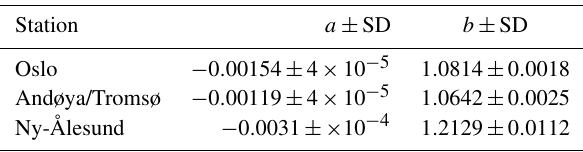
Figure 3. GUV TOC from Ny-Ålesund measured throughout two selected periods: April 2018 (a) and June 2018 (b) . Table 2. Results from statistical fit of GUV / Brewer(and SAOZ) ratio: a is the slope and b is the constant in Eq. (4). The standard deviation (SD) of the coefficients is included.